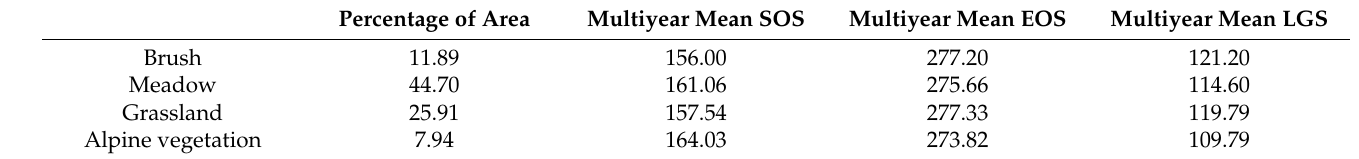
Figure A1. Vegetation types in the Qilian Mountains. These data were extracted from The Vegetation Map of the People’s Republic of China (VMC, 1:1,000,000) (Editorial Committee of Vegetation Map of China, CAS, 2007) (http://www.resdc.cn/data.aspx?DATAID=122). Table A1. The vegetation phenology of the main vegetation types in the Qilian Mountains.